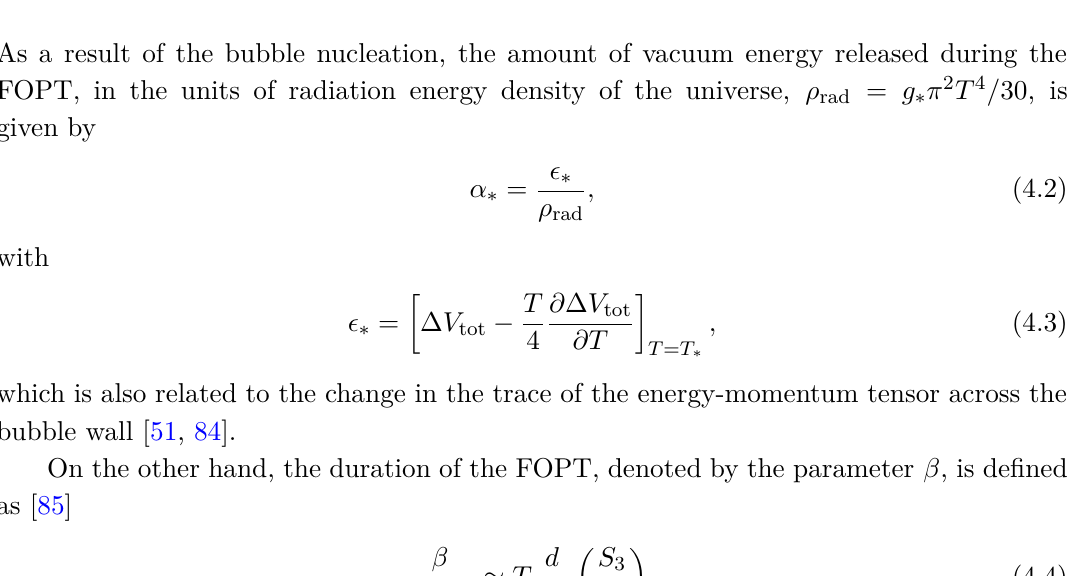
Figure 1 . Shape of the potential at, above and below the critical temperature T c for chosen benchmark points shown in table